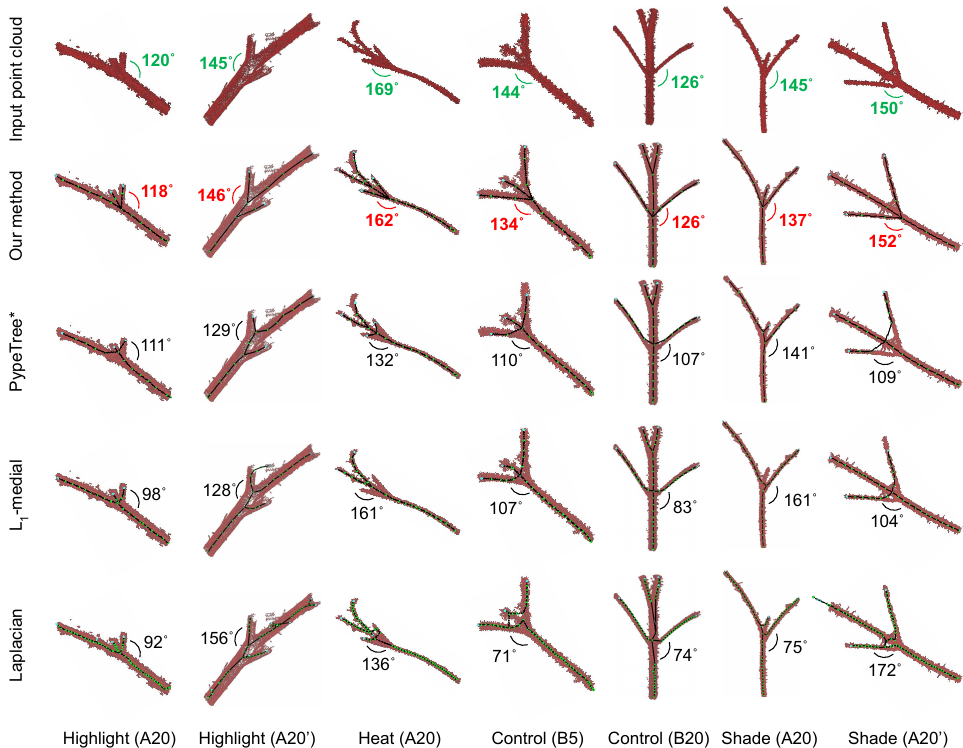
Figure 6. Branch angle prediction for four methods. Seven forks are shown (columns), each from tomato plants across different conditions. The name “Highlight (A20)” means the fork comes from a plant grown in highlight conditions scanned on developmental day 20. Plants are given names “A” or “B” for replicates. The apostrophe symbol denotes a different fork that belongs to the same plant. Each row shows the skeletons and estimated angles for each of the four methods; the top row shows the ground-truth angle, computed manually. Only one angle is highlighted in each